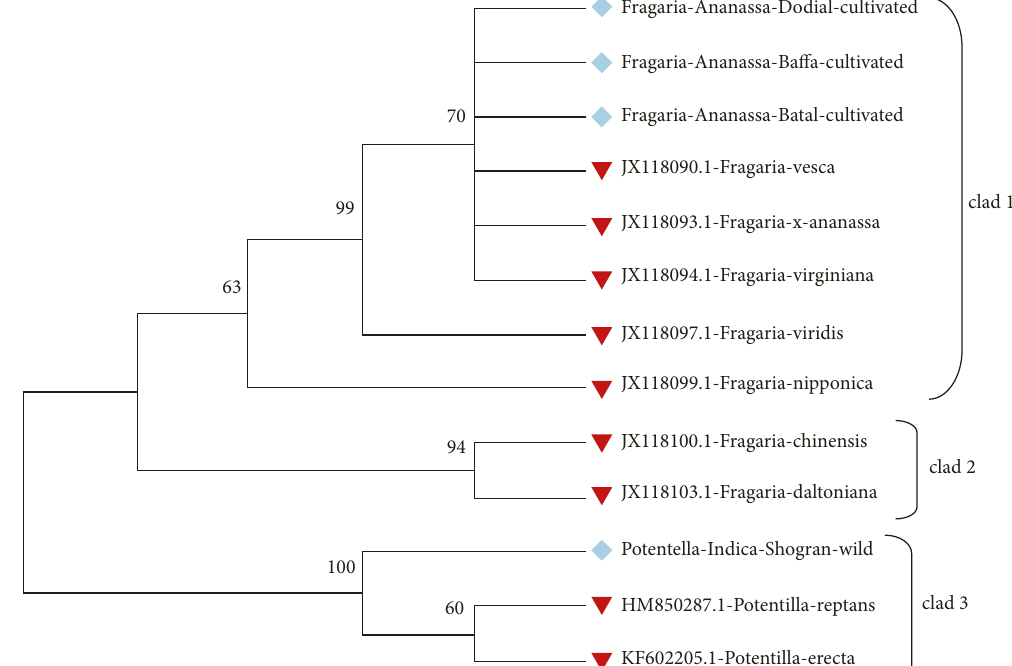
Figure 15: Phylogenetic tree analysis of Fragaria species (rbclC) with reference species through using the maximum likelihood